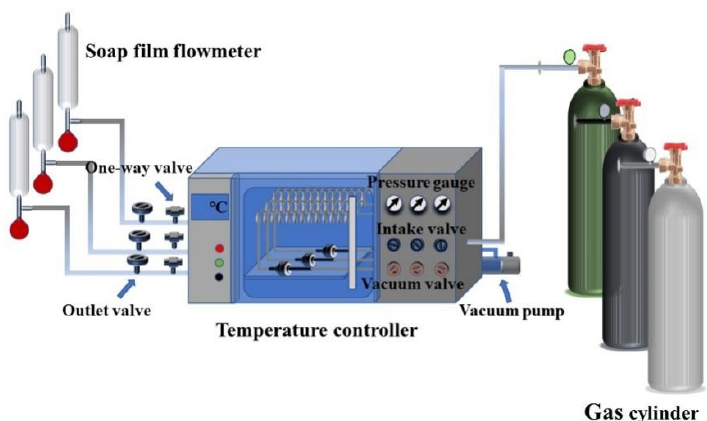
Figure 2. Single gas permeation experiment device diagram.